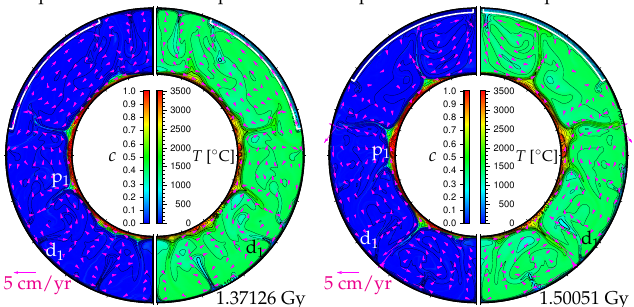
Figure 9. Snapshots of the thermochemical states of Case 4 at the elapsed times indicated in the figure. In the snapshots both for the distributions of composition c and temperature T , the purple arrows indicate the velocity vectors (cid:126) v and thin black lines are the iso-lines of temperature T . The meanings of the colors and thick white lines are the same as in Figure 4. See the text for the meanings of the regions labeled “P 1 ”–“P 3 ”, “p 1 ”–“p 3 ” and “d 1 ”–“d 3